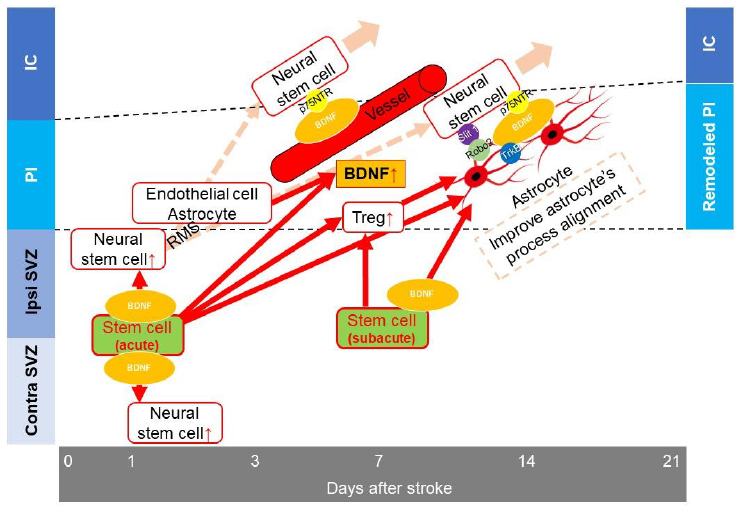
Figure 3. Neurogenesis. After ischemic stroke, the proliferation of neural stem cells in the subven- tricular zone (SVZ) increases. These cells migrate to the injury site via the rostral migratory stream (RMS). Astrocytes and endothelial cells secrete brain-derived neurotrophic factor (BDNF). Three to fifteen days post ischemic stroke, neural stem cells (NSCs) migrate into the periinfarct area along